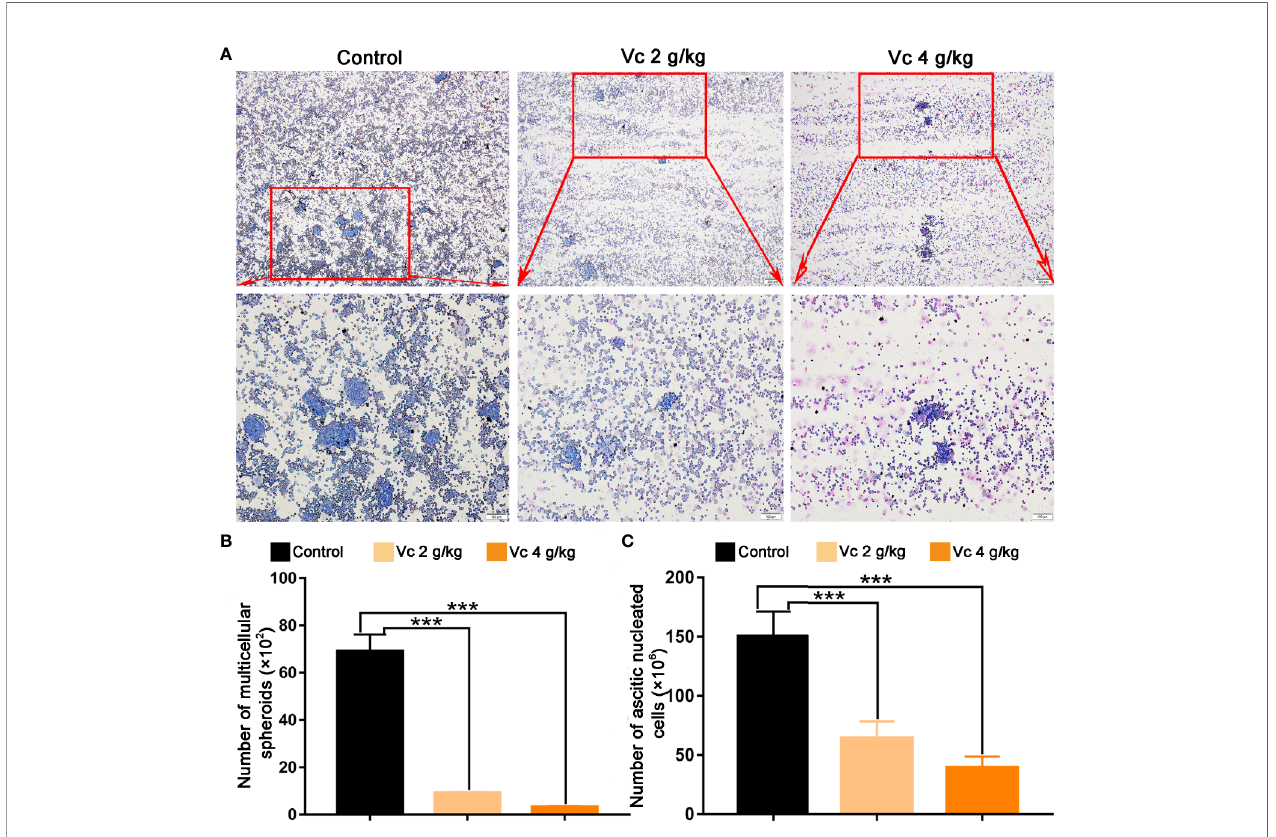
FIGURE 2 | Vitamin C prevents multicellular spheroid formation in ID8 tumor-bearing mice. (A) Representative images of multicellular spheroids from the ascitic fl uid. upper panels ×40 and lower panels ×100. (B) The quantitation of multicellular spheroids from ascitic fl uid. Data are mean ± SEM; n=5. ***p < 0.001. (C) Ascitic fl uid nucleated cell counts in different groups. Data are mean ± SEM; n=8. ***p <